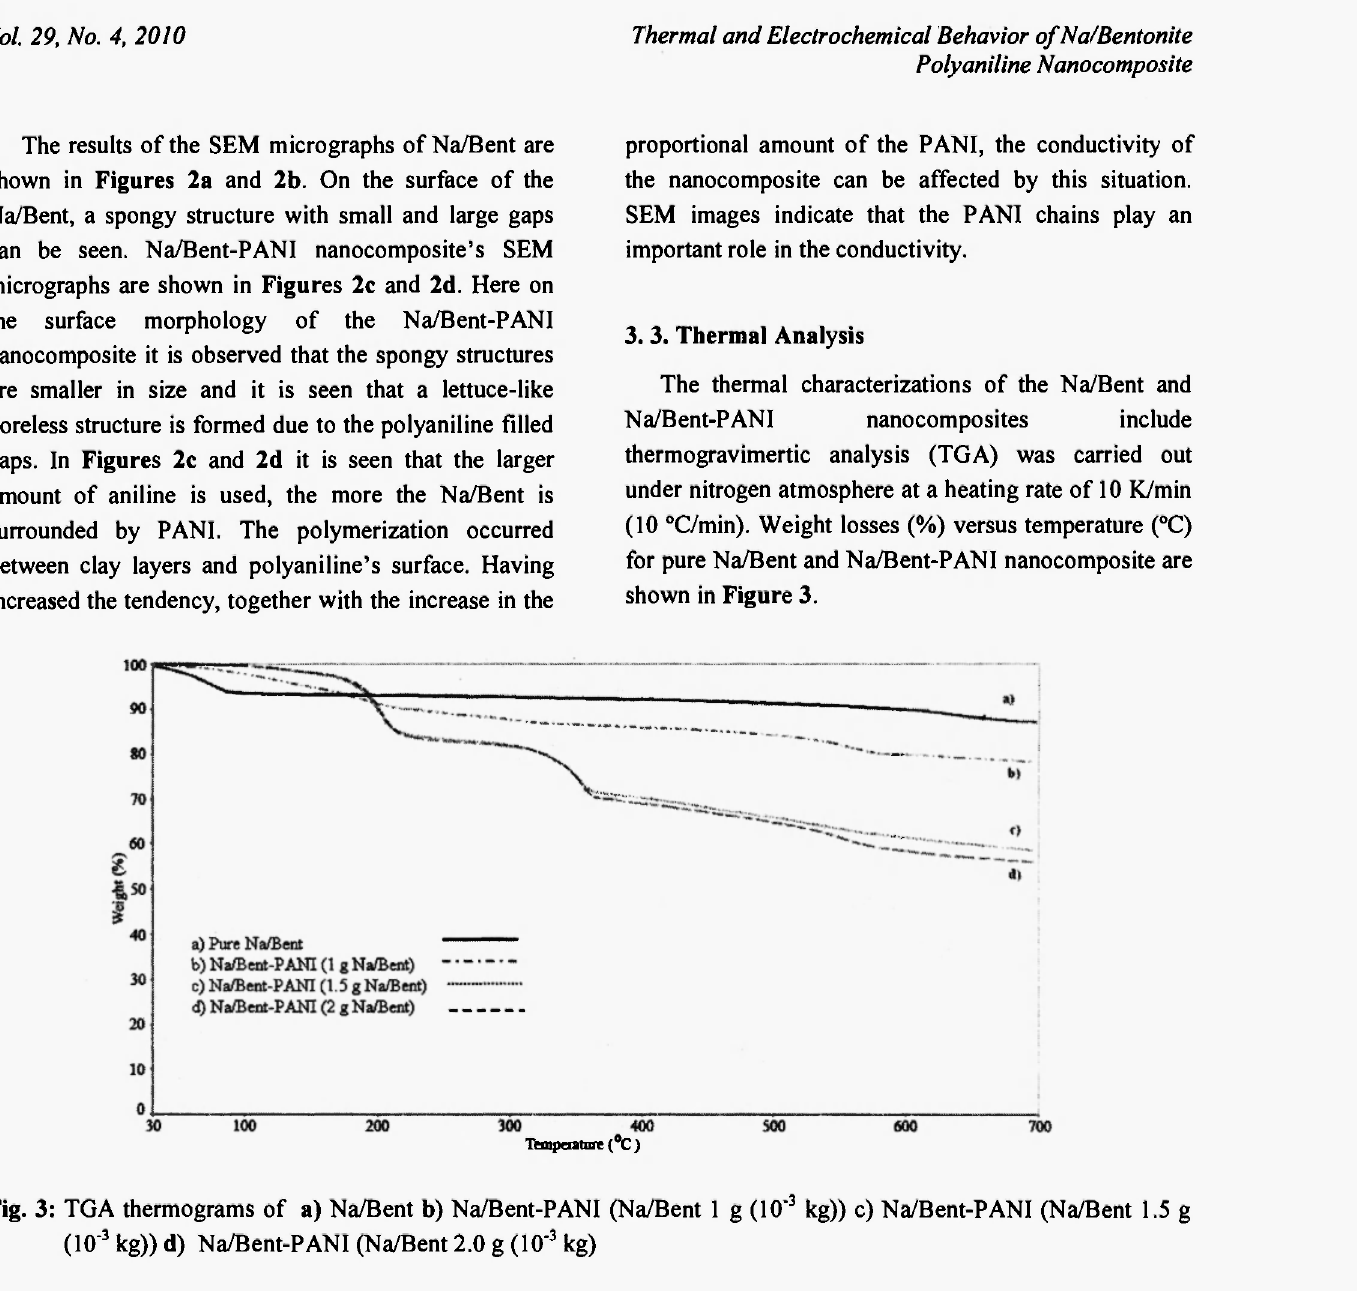
Fig. 3: TGA thermograms of a) Na/Bent b) Na/Bent-PANI (Na/Bent 1 g (10 3 kg)) c) Na/Bent-PANI (Na/Bent 1.5 g (10 3 kg)) d) Na/Bent-PANI (Na/Bent 2.0g(10" 3